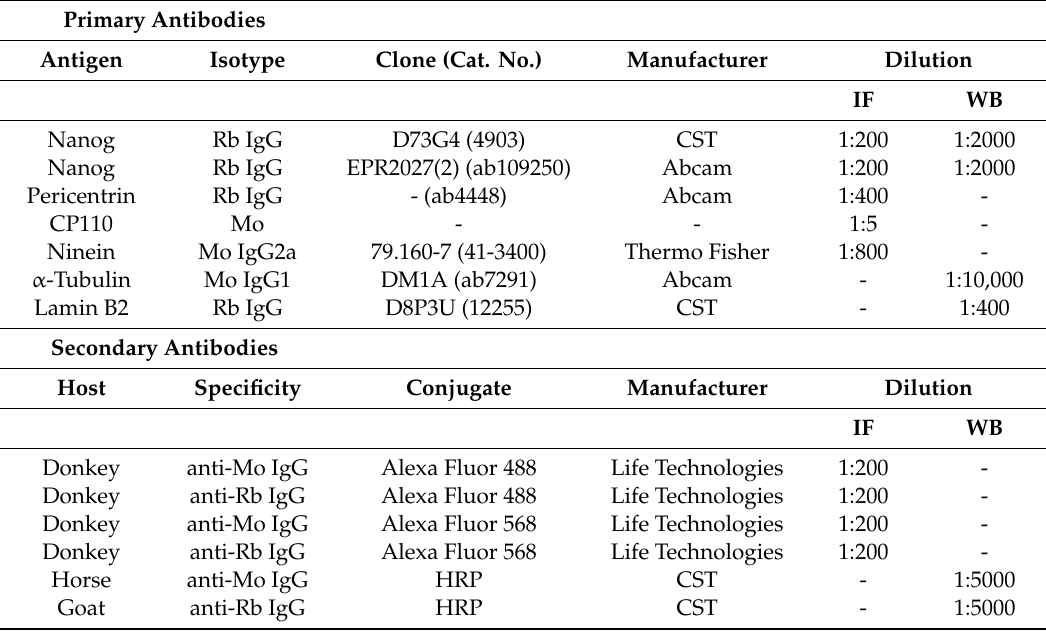
Table 2. Antibodies used in the